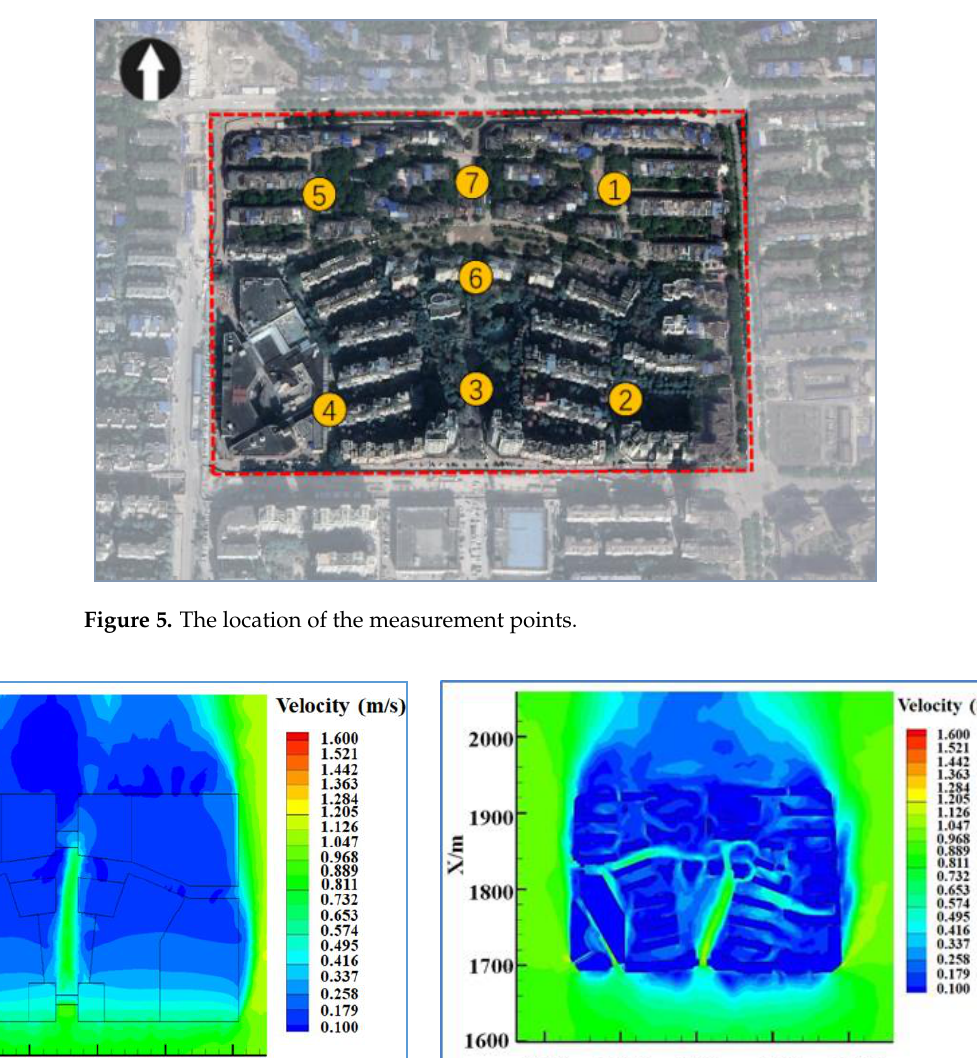
Table 1. Boundary setting details of standard method and porous method.